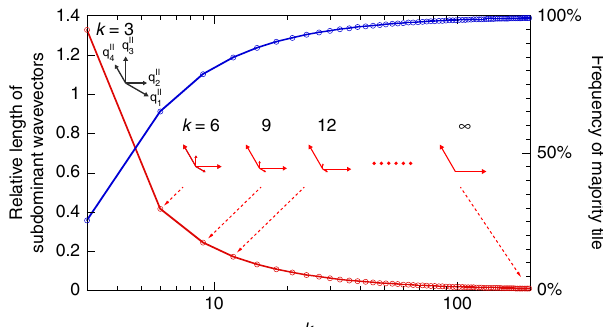
Fig. 4 Convergence towards periodic hexagonal lattice. Ratio of magnitudes of subdominant and dominant reciprocal-space basis vectors (red points connected so as to guide the eye) and the frequencies of majority tiles in type IA tilings (blue points) vs. k . Also included are the reciprocal-space basis vectors for k = 3, 6, 9, 12, and ∞